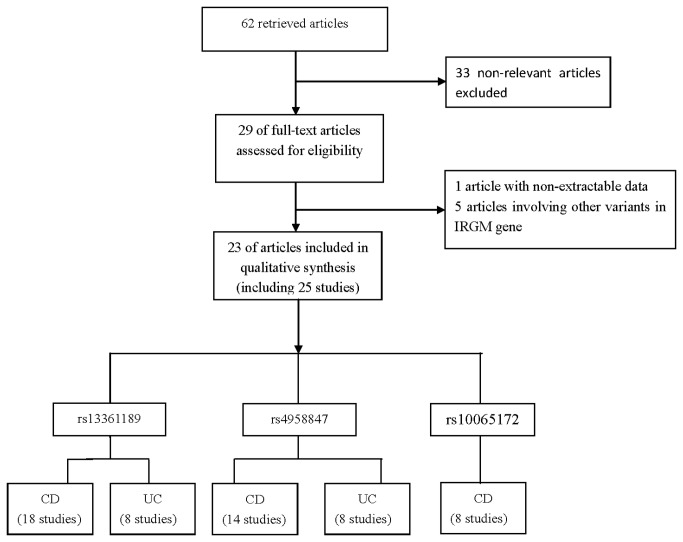
Flowchart of search strategy for meta-analysis.